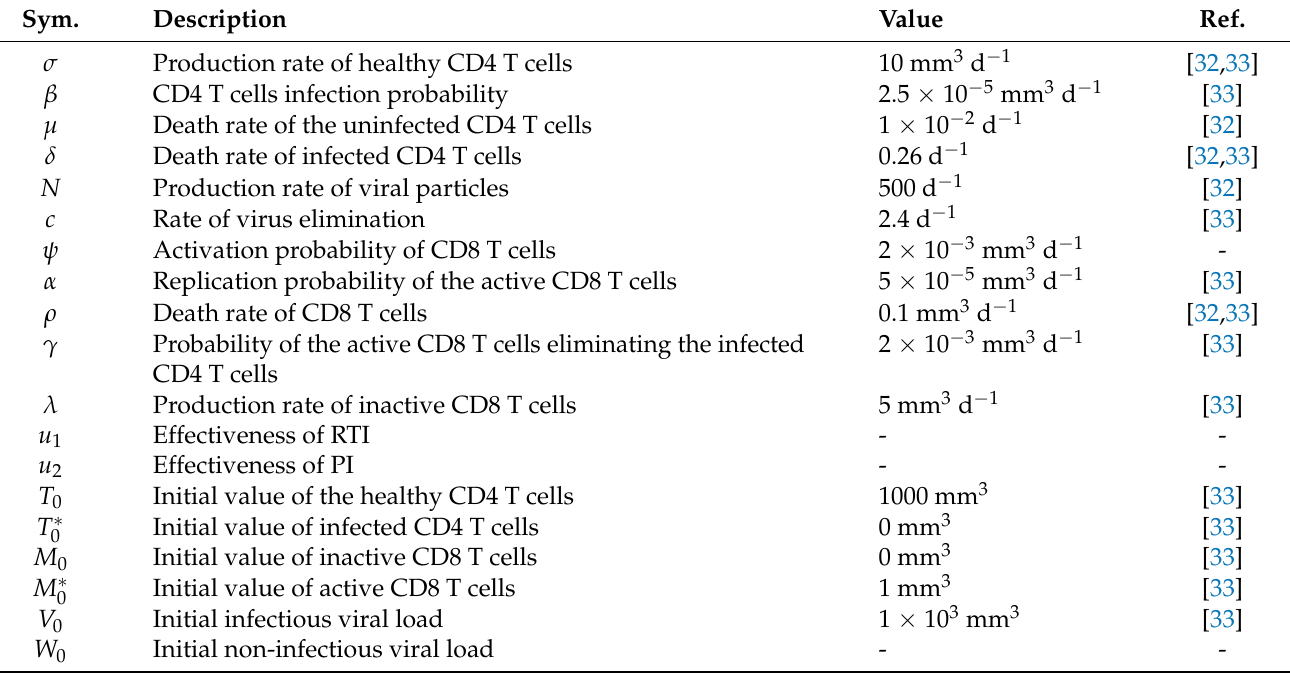
Table 2. Description of parameters for model (7) and baseline values used in the simulation, with their respective source.